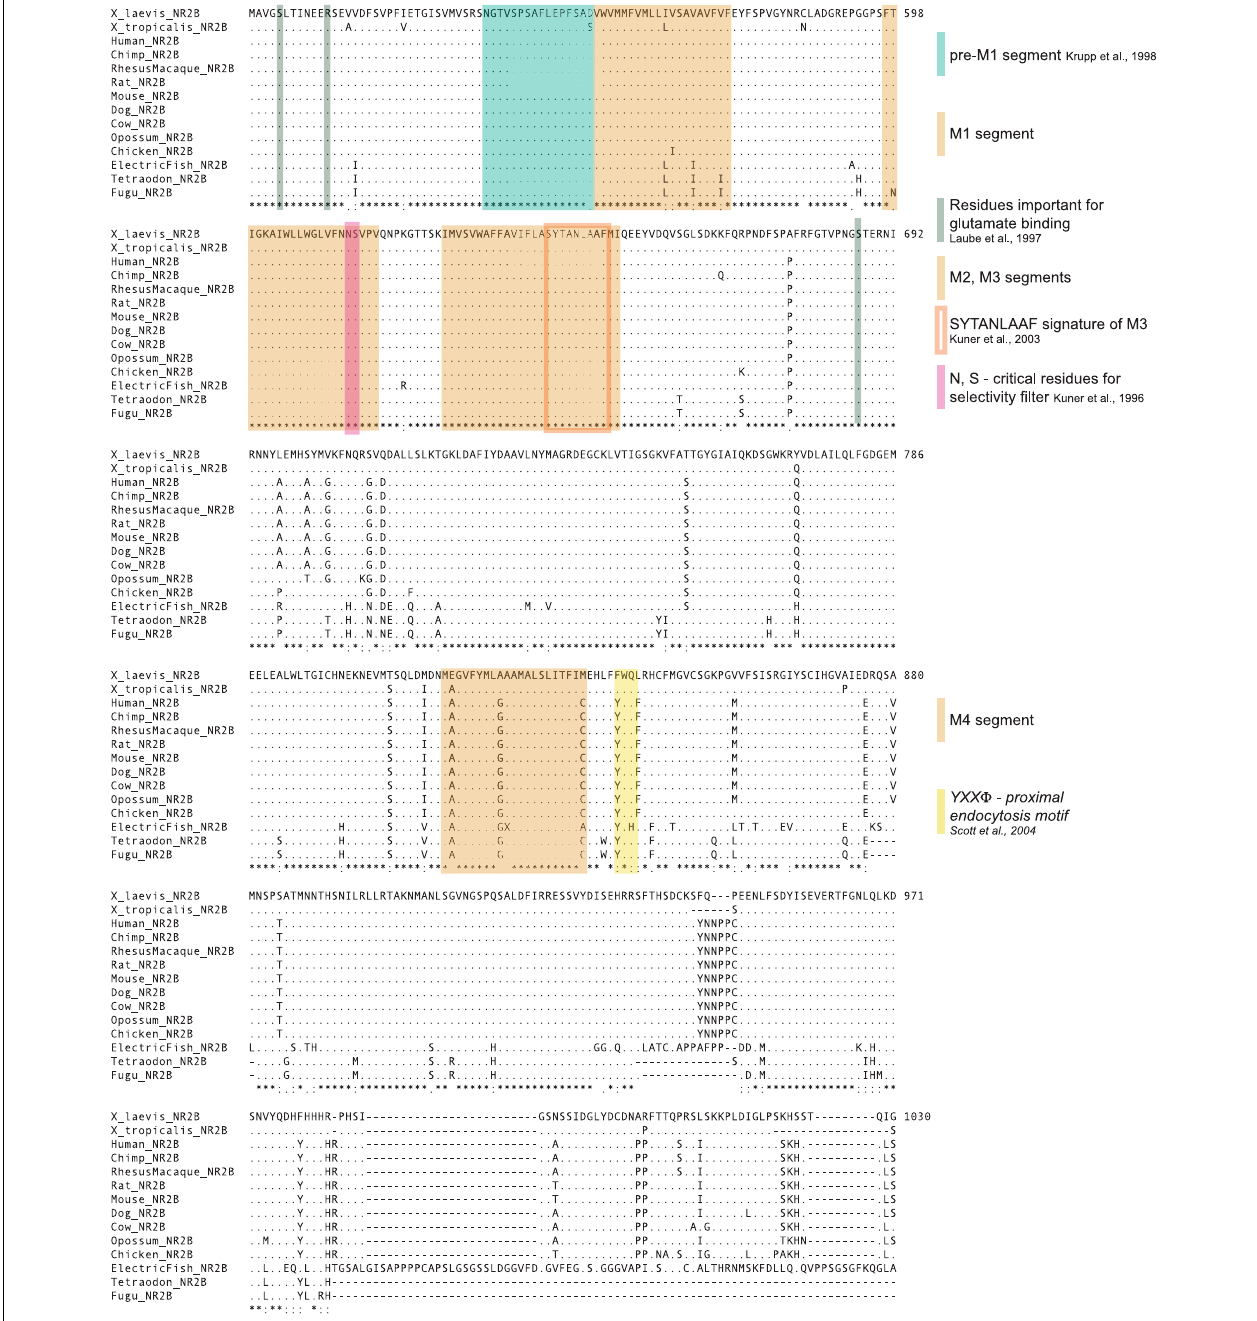
(:) and (.) indicate the degree of amino acid similarity. NR2B is very highly conserved between species. The membrane-associated segments M1–M4, other structurally and functionally important domains and amino acids, as well as known protein–protein interaction domains and phosphorylation sites are highlighted. Descriptions in italics indicate sites that are not conserved between